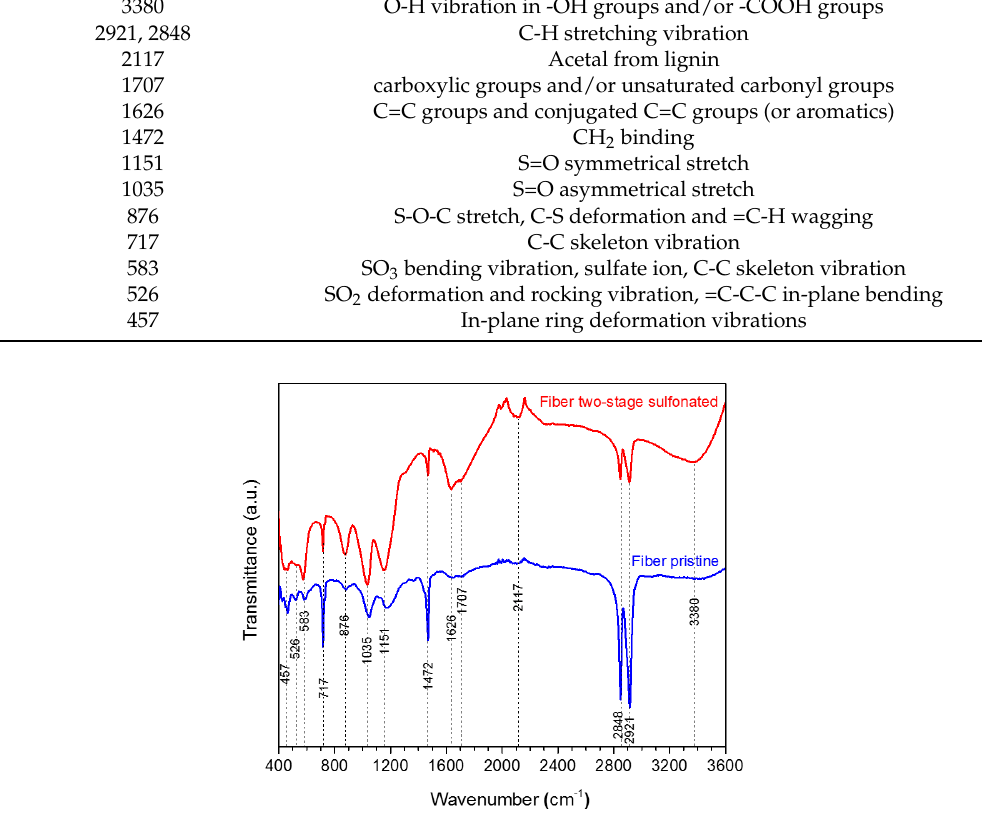
Figure 5. FTIR spectra of HDPE/SKL (90:10) fiber prior to, and after, sulfonation.